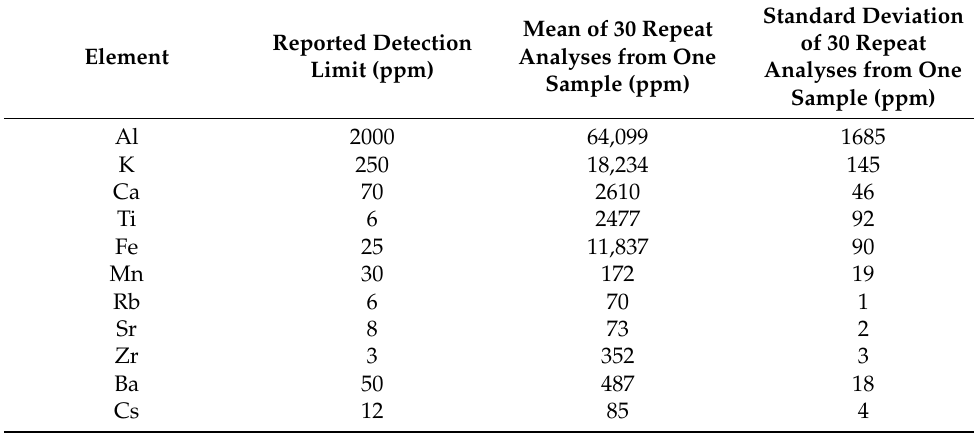
Table 1. Factory reported detection limit for some key elements plus mean and standard deviations of one sample analysed 30 times to assess credibility of reported concentration data. Standard Deviation Mean of 30 Repeat of 30 Repeat Reported Detection Analyses from One Element Analyses from One Limit (ppm) Sample (ppm) Sample (ppm)